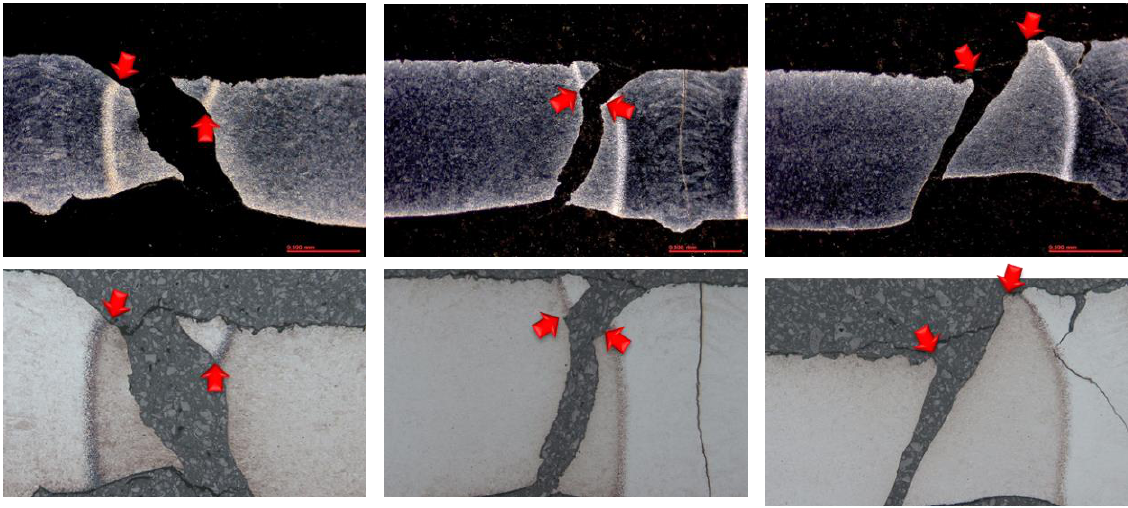
Figure 11. Fractured specimens after tensile test.